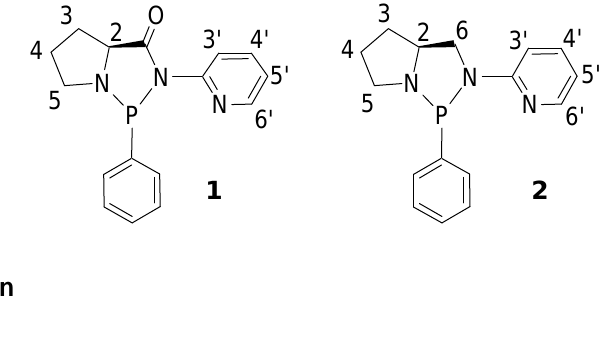
Figure 1. The ligands studied and their numbering